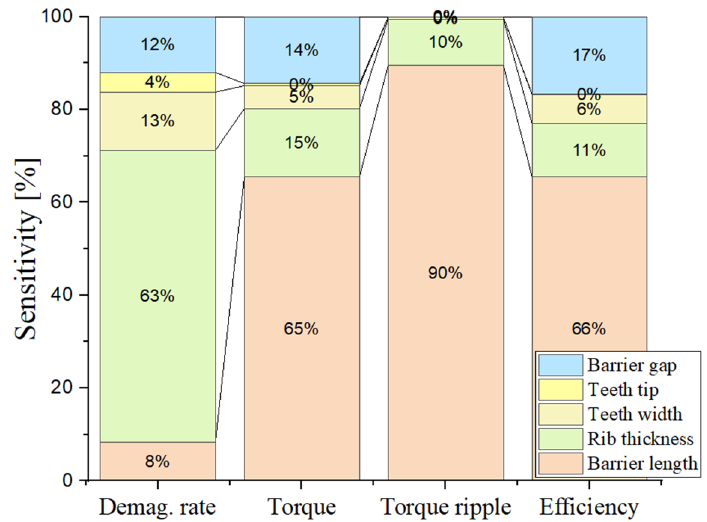
Figure 7. Sensitivity analysis using screening.